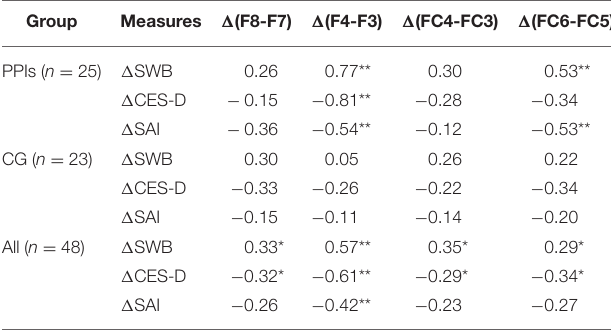
TABLE 4 | Bivariate correlations between changes of self-reported outcome measures and changes of frontal EEG asymmetry for each group and across all participants.